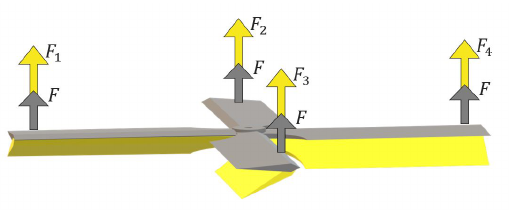
Figure 2. Collective control changes the angle of attack of all blades at the same time. The main rotor is in the grey position, horizontal to the ground, if not actuated. A maneuver of the collective control brings the blades to rotate independently to the yellow configuration. The force generated by each propeller is represented by F in the standard configuration and by F 1 = F 2 = F 3 = F 4 in the collective controlled